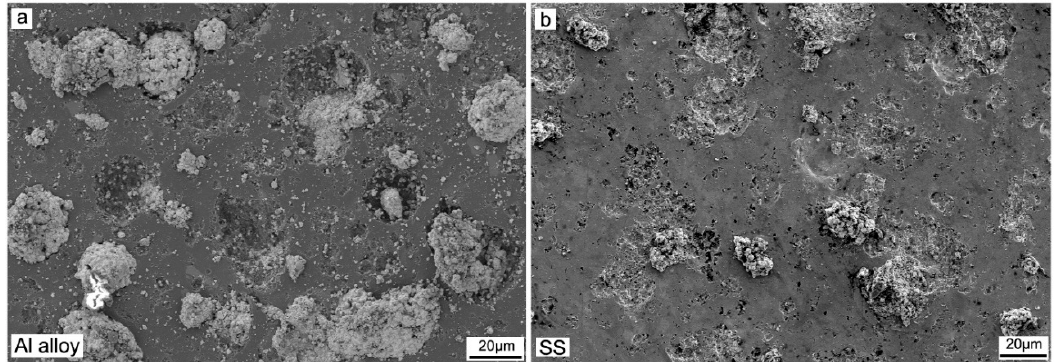
Figure 7. SEM imaging of substrate surface morphology after impacted by WC-Co particles: ( a ) Al alloy and ( b ) SS substrates.